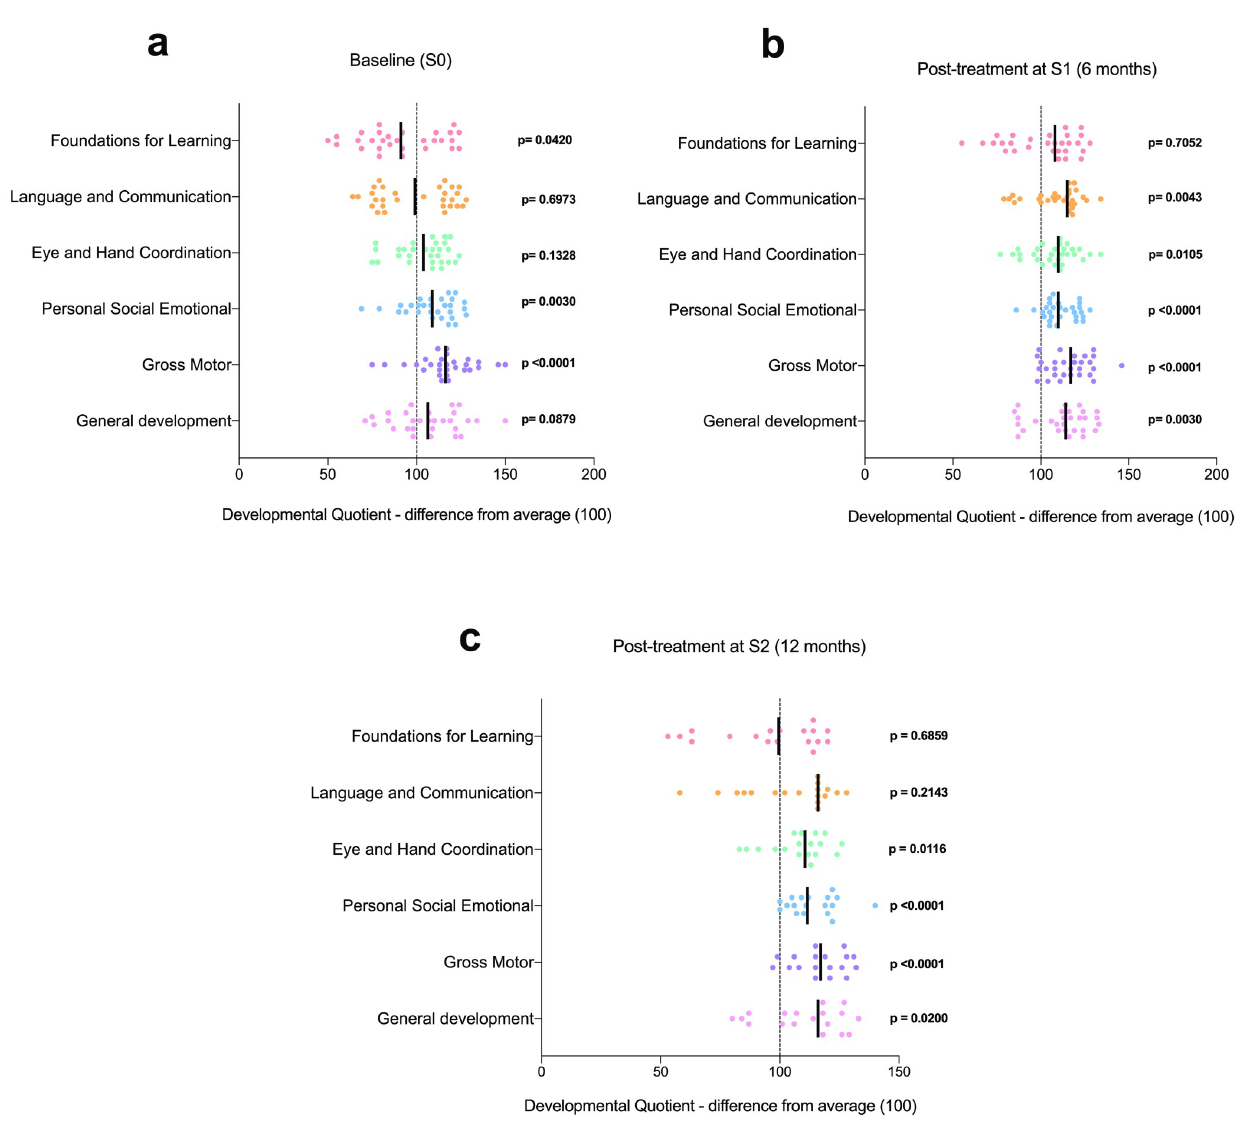
Fig 4. Six- and 12-month time course of developmental quotient (DQ) scores for treated S . haematobium positive children. Scatterplots show DQ scores for a) children positive and treated for S . haematobium infection at baseline (n = 29), b) children present at S1 survey (6 months later) and tested negative for S . haematobium infection (n = 29), and c) children present at S2 survey (12 months later) who remained negative for S . haematobium infection (n = 18). Dotted lines represent the mean reference average for DQ (100). p-values indicate statistical tests for either a one sample t-test or Wilcoxon sign test (based on normality) comparing to the hypothetical mean of 100. Solid lines =